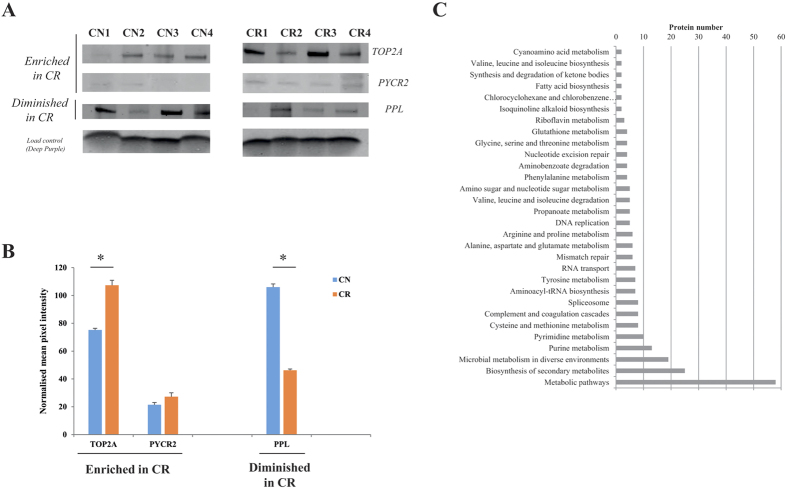
Validation of differentially regulated proteins between CN and CR non-adherent cellular-derived patient samples.(A) Representative Western blots of cellular proteins derived from non-adherent spheroid ascites tumor populations from CN (4 individual patient replicates) and CR (4 individual patient replicates) samples. Proteins examined are TOP2A, PYCR2 and PPL. Total protein load was obtained by staining the membrane with Deep Purple. (B) Densitometry analysis was performed using ImageStudio v5, with mean pixel intensity normalized to background. Data is expressed as mean ± SEM of n = 4 samples/group performed in triplicate. Significance was determined using Student’s t-test with *p < 0.05 considered statistically significant (C) KEGG pathway enrichment analysis of proteins identified enriched in CR. Proteins identified enriched in CR vs CN (based on label-free spectral counting, Rsc > 2, Fisher’s exact test <0.05) were functionally annotated to identify enriched biological pathways using the KEGG database. Only significantly enriched KEGG functional categories (p < 0.05) are depicted according to their protein number. The analysis yielded a strong significance for proteins associated with ‘energy metabolism’ and ‘DNA mismatch repair mechanisms’ pathways.